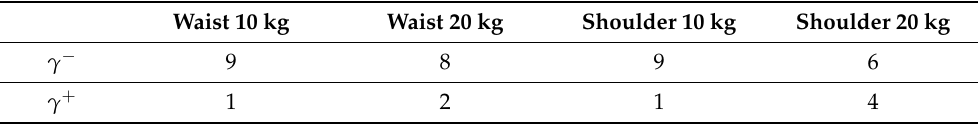
Table 1. Number of subjects γ − for which the exoskeleton use results in a reduced RMS muscle activation ( ρ i < 1) and number of subjects γ + for which the exoskeleton use results in an increased mean muscle activation ( ρ i > 1), for each combination of pulling height (waist and shoulder) and box weight (10 and 20 kg).